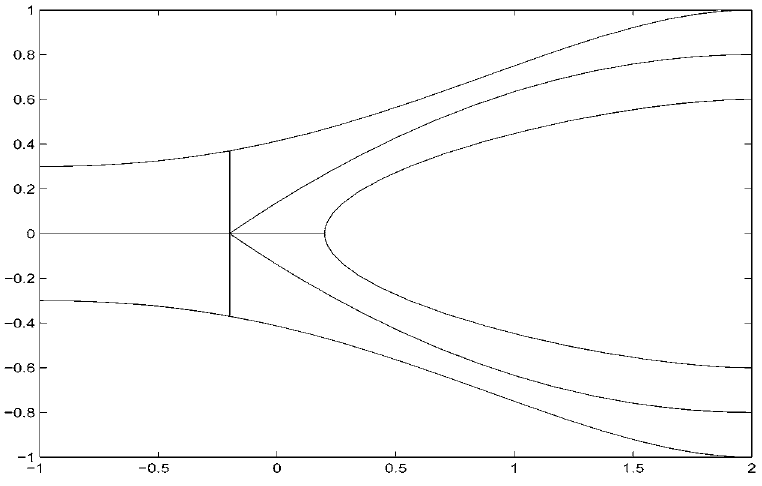
Figure 2. The reference bifurcation B ˆ constructed from six